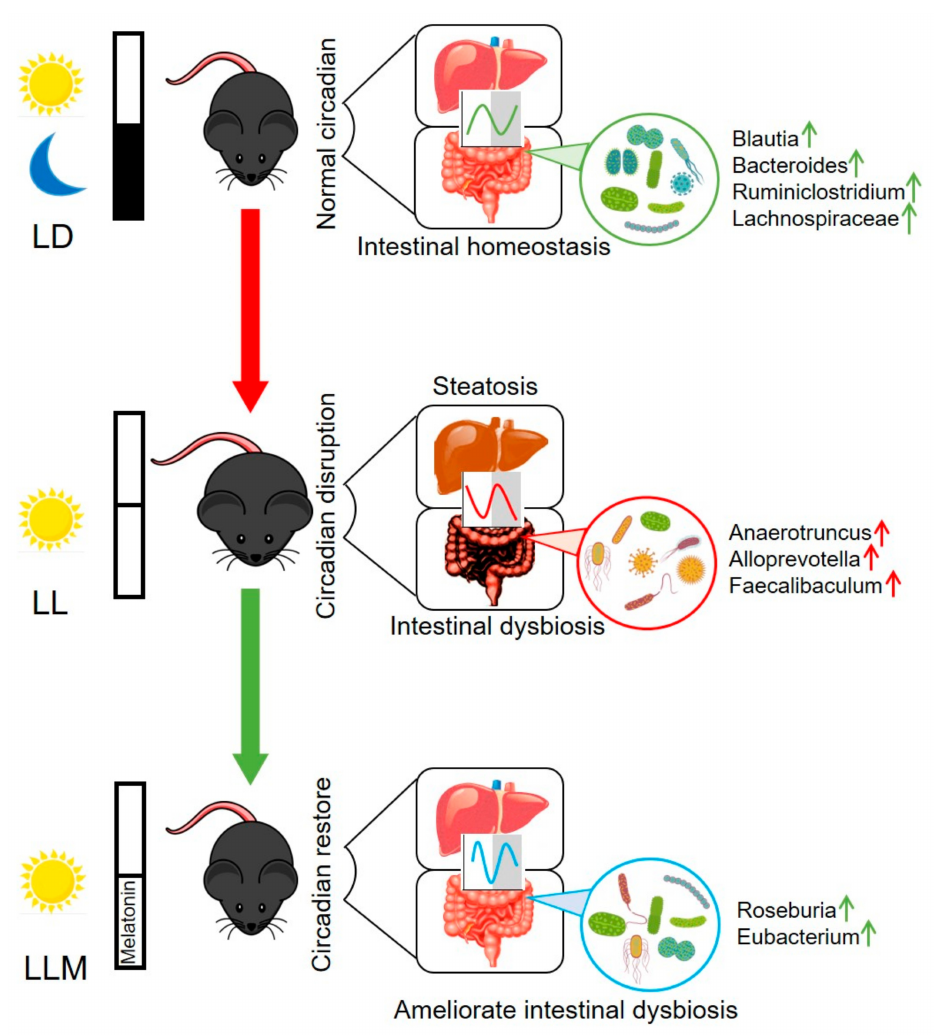
Figure 9. Schematic illustration of our proposed model. Melatonin restores the circadian clock and ameliorates intestinal dysbiosis during continuous light. LD: 12-h light–12-h dark cycle; LL: 24-h light condition; LLM: mice in the LL that were supplemented with melatonin daily (50 mg / kg / d) in water but only during ZT12 to ZT24. Mice were prone to obesity and showed metabolic disorders, including liver steatosis and intestinal dysbiosis, during LL conditions. Melatonin inhibited weight gain by modulating circadian rhythm and restoring microbiota composition in LL conditions. Red arrows represent bacteria that are prone to increase in obesity; green arrows represent prebiotic bacteria that are